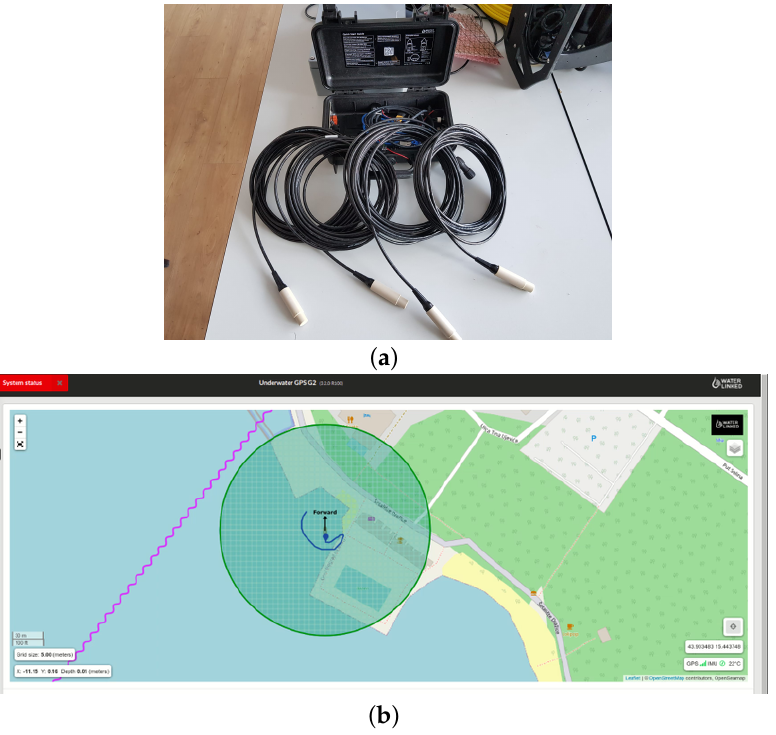
Figure 13. ( a ) WaterLinked Underwater GPS G2 topside with 4 transducers for underwater acoustic localization. ( b ) Web GUI on the topside computer that allows system setup and visual tracking of the ROV on a georeferenced map.